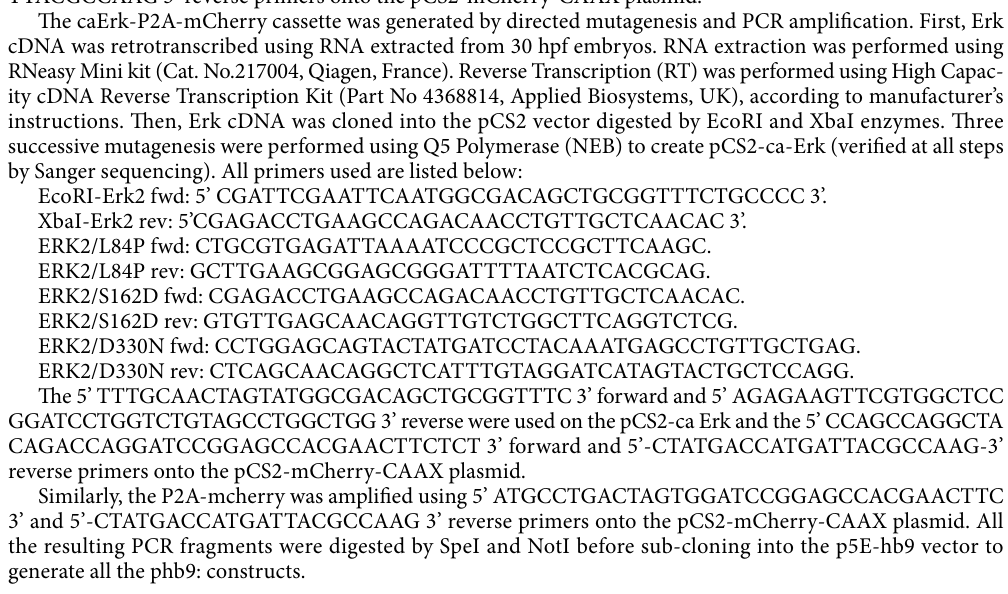
Figure 8. Rgs4 function, Akt and Erk activities that mediate Rgs4-dependent motoneurons outgrowth are all required within motoneurons. ( A ) Representative maximum projections of z-stack optical sections of CaP and MiP at 30 hpf following injection of different constructs allowing the expression of mcherry in WT and MZrgs 4, Rgs4-P2A-mcherry in MZrgs4 , caAkt-P2A-mcherry in MZrgs4 and caErk-P2A-mcherry in MZrgs4 specifically in motoneurons under the control of hb9 promoter. ( B ) Quantification of individual CaP motor axons length following injection of hb9:mcherry in WT (average of 84.33 ± 3.48 μm, 6 CaP, n = 4) and MZrgs4 (30.57 ± 4.41 μm, 7 CaP, n = 5), injection of hb9:rgs4-P2A-mcherry in MZrgs4 (average of 76 ± 4.91 μm, 4 CaP, n = 4), injection of hb9:caAkt-P2A-mcherry in MZrgs4 (average of 89.67 ± 8.24 μm, 6 CaP, n = 6) and injection of hb9:caErk-P2A-mcherry in MZrgs4 (average of 87.67 ± 5.73 μm, 6 CaP, n = 6). ( C ) Quantification of individual MiP motor axons length following injection of hb9:mcherry in WT (average of 54.20 ± 0.66 μm, 5 MiP, n = 4) and MZrgs4 (20 ± 3.23 μm, 6 MiP, n = 5), injection of hb9:rgs4-P2A-mcherry in MZrgs4 (average of 52 ± 0.82 μm, 4 MiP, n = 4), injection of hb9:caAkt-P2A-mcherry in MZrgs4 (average of 58 ± 1.92 μm, 5 MiP, n = 5) and injection of hb9:caErk-P2A-mcherry in MZrgs4 (average of 55.71 ± 2.05 μm, 7 MiP, n = 7). ns, non